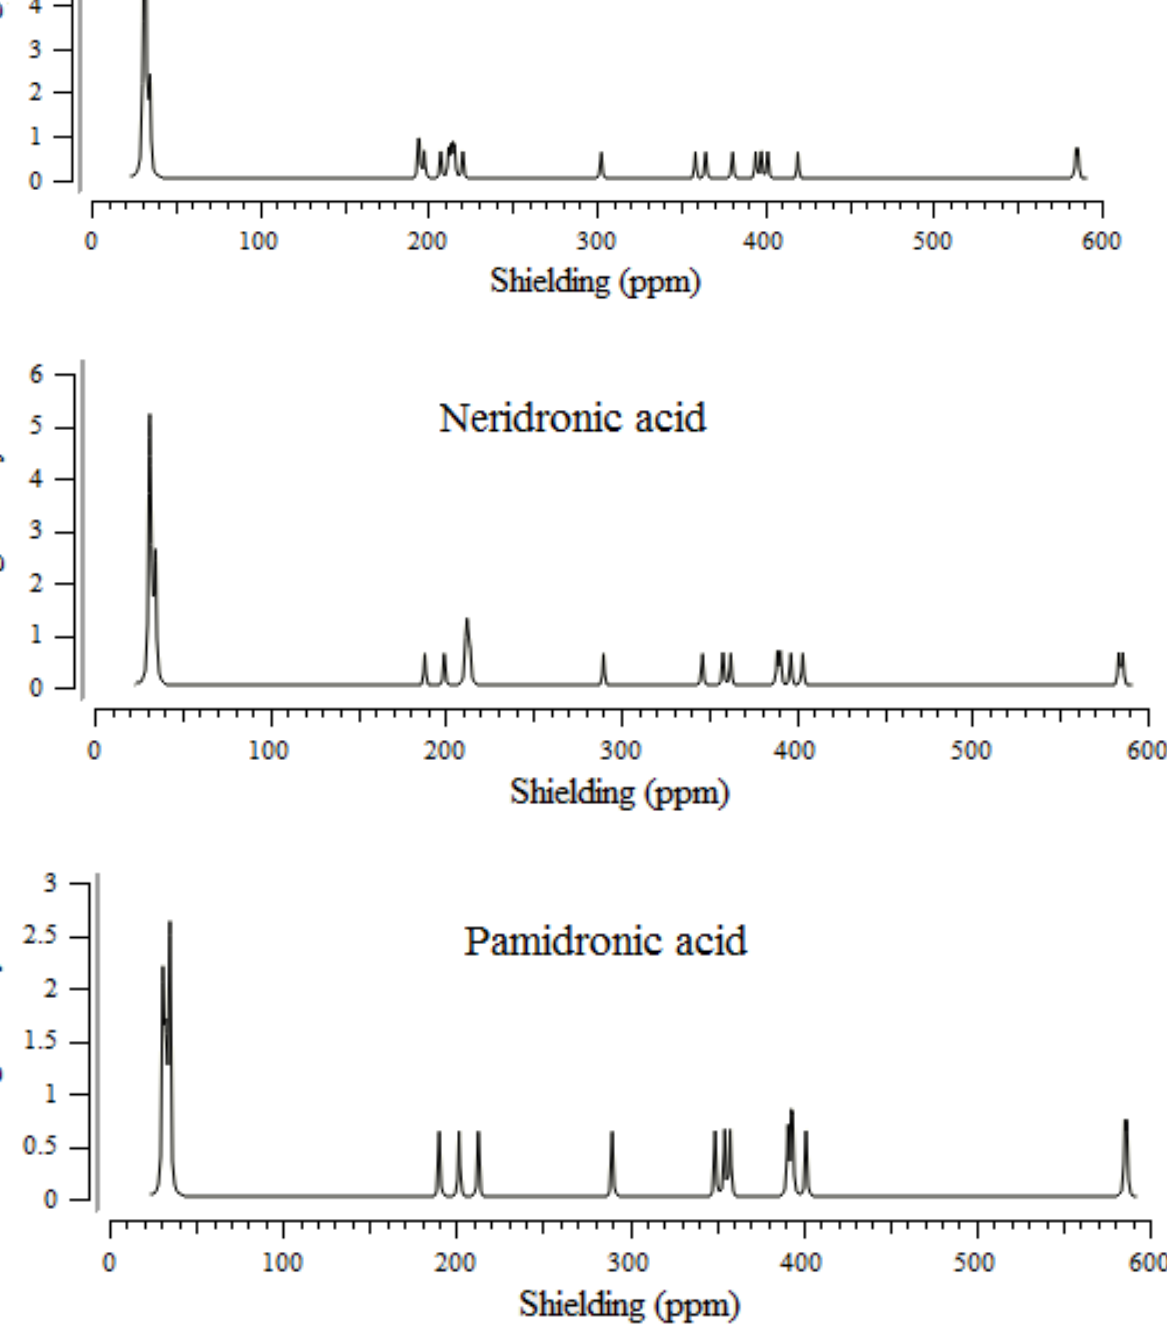
Figure 1. NMR spectra for alendronic acid, ibandronic acid, neridronic acid, and pamidronic acid in ppm conjugated on the surface of (6, 6) armchair CNT.